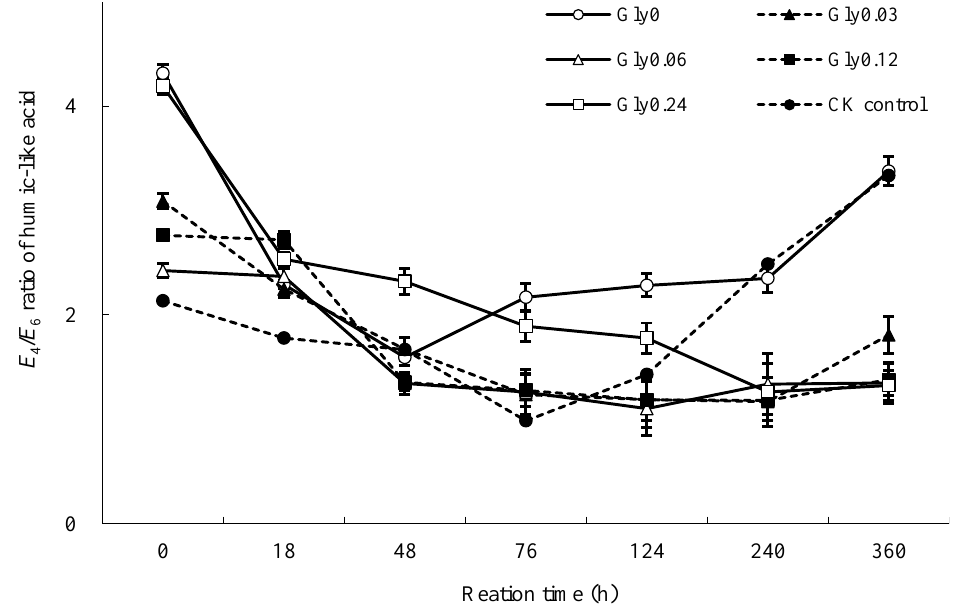
Figure 6. Effects of the glycine with different concentrations in the Maillard precursors on the E 4 / E 6 ratio of diluted liquid sample of humic-like acid extracted from the dark-brown residue. Table 2. Atomic ratios of the humic-like acid extracted from the dark-brown residue under differ- ent glycine concentrations in the Maillard precursors.